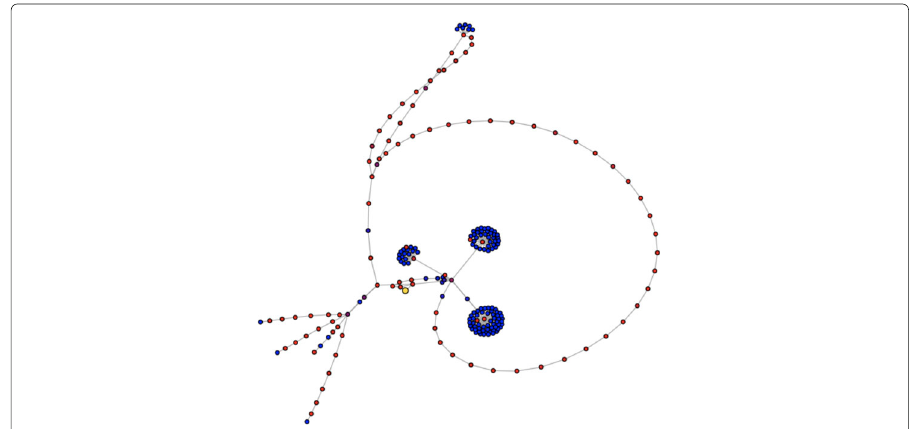
Fig. 1 Sample Hack Subnetwork, Hack A3 boundary of the networks generated, see Fig. 2. In some cases, when the level of obfuscation is minimal, investigations tracking stolen funds often terminate at ser- vices (see Methodology section on identifying services), simply because criminals want to change their stolen bitcoin for fiat currency, or at least convert it to a another